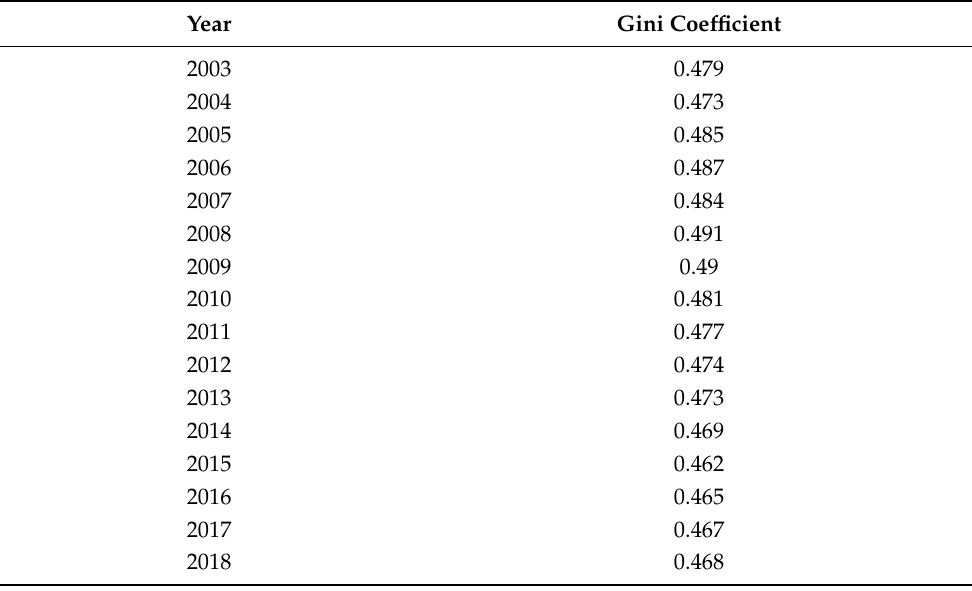
Table A2. National Gini coefficients of per capita disposable